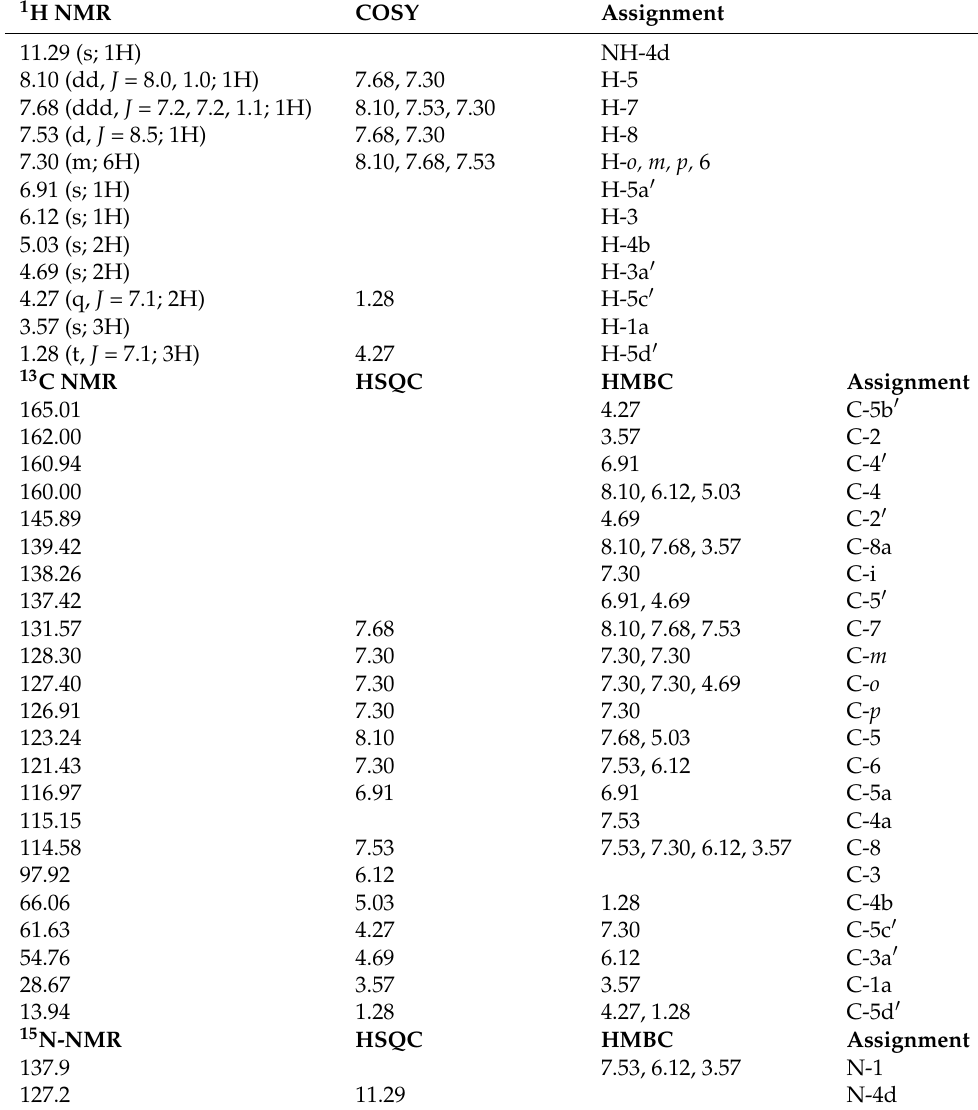
Table 1. NMR spectroscopic assignments of compound 7b